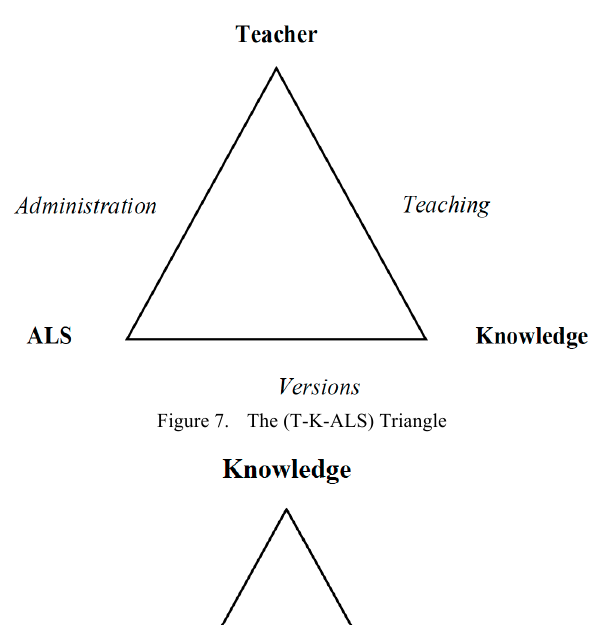
Figure 6. The (T-L-ALS) Triangle